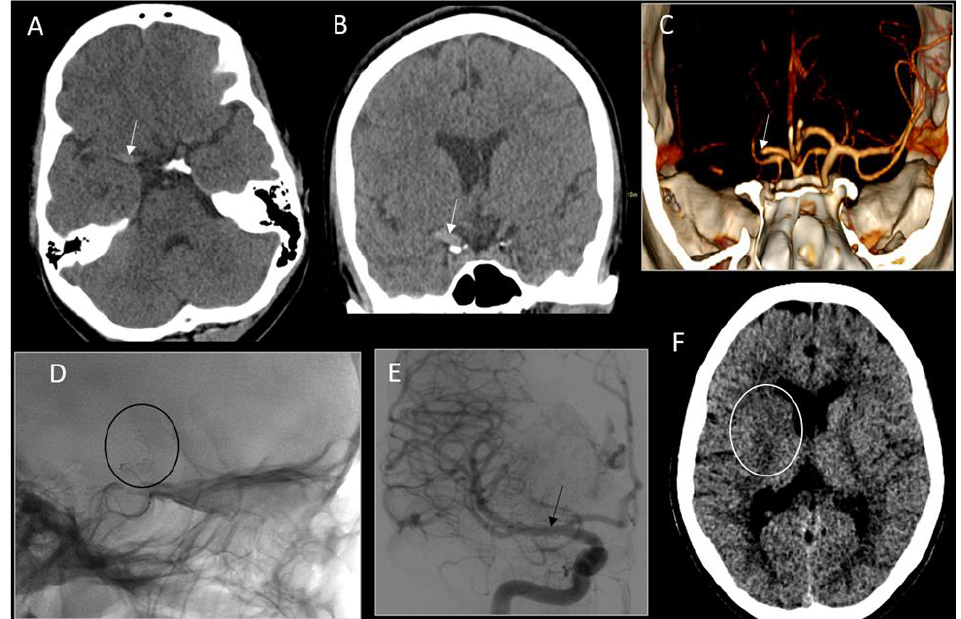
Figure 1. Neuroimaging of acute ischemic stroke and treatment. ( A , B ) Computed tomography angiogram of the head showing hyperdense middle cerebral artery (white arrows; ( A ) axial, ( B ) coro- nal). ( C ) Reformatted computed tomography angiogram of the head and 3D coronal demonstrating an abrupt cutoff of the right middle cerebral artery (white arrow). ( D , E ) Conventional cerebral angiogram showing stent retriever deployed across the right middle cerebral artery clot (( D ) sagittal image, black circle) and, after successful clot retrieval, showing recanalized middle cerebral artery (( E ) black arrow). ( F ) Non-contrast axial computed tomography of the head 24 h after intravenous tissue plasminogen-activator and thrombectomy showing ischemia limited to the right basal ganglia (loss of right caudate gray-white matter differentiation, white circle) without hemorrhagic